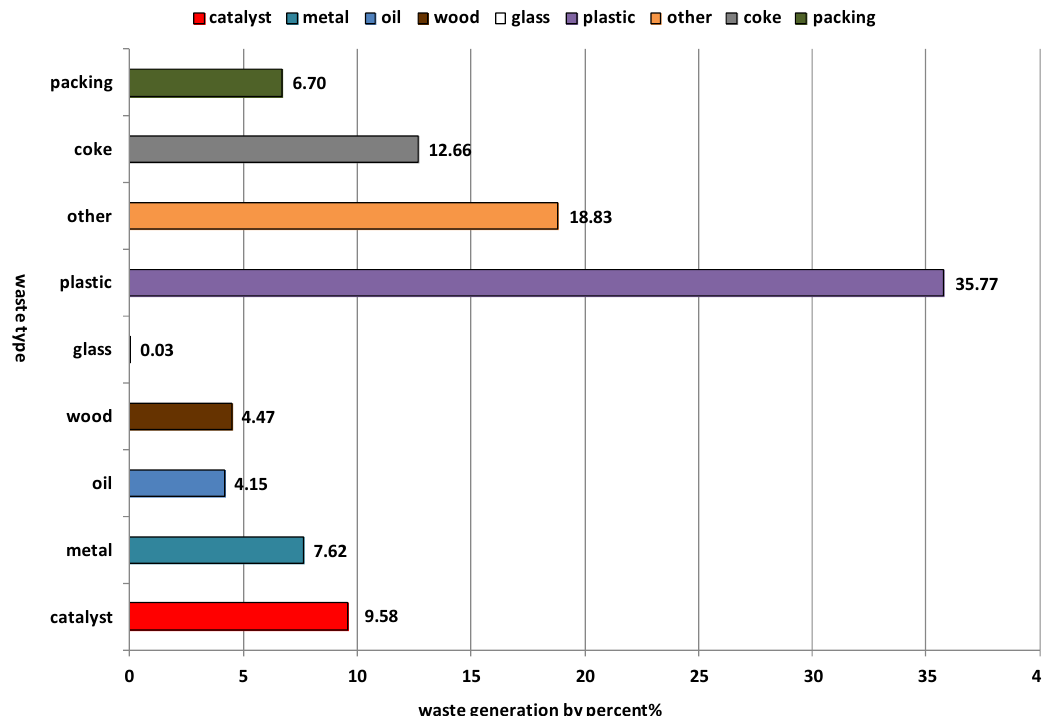
Figure 3: Composition generated waste in Amirkabir petrochemical complex Process